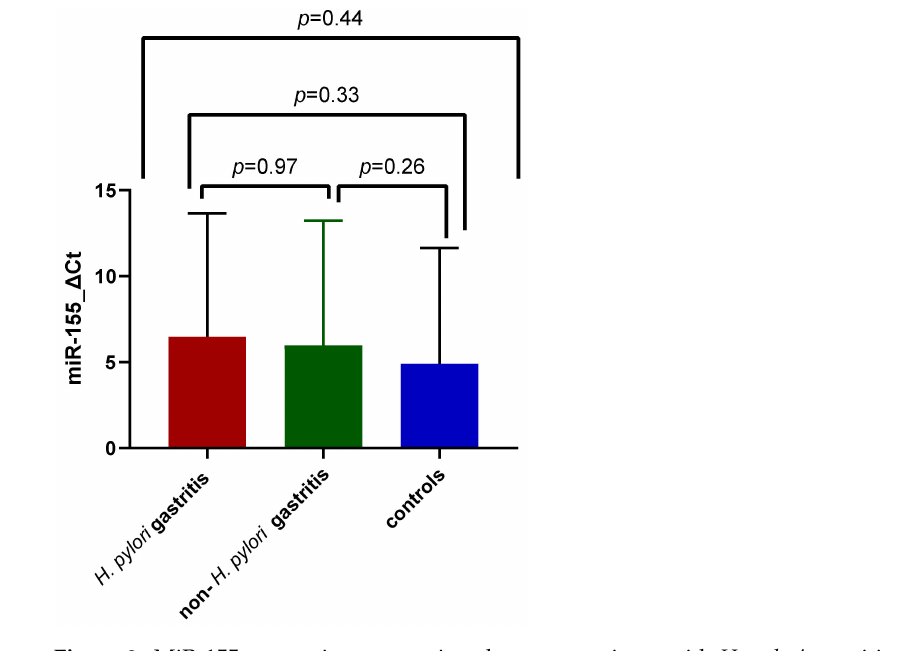
Figure 2. MiR-155 expression comparison between patients with H. pylori gastritis, non- H. pylori gastritis, and control group.